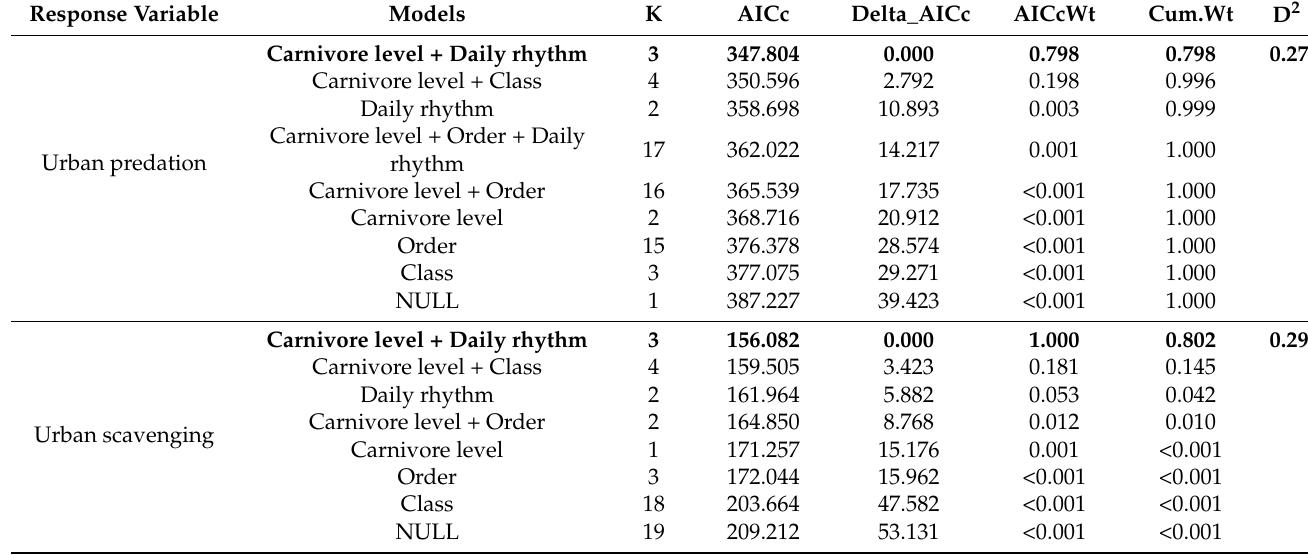
In urban predation and scavenging studies, the most recorded species were those with meat-based diets and nocturnal activity (Table 3). In both sets, there were other models that included the explanatory variables carnivorous level and class (Table 3), at only a few tenths above the threshold of 2 ∆ AICc. The selected models explained an important fraction of the deviance (0.27 in the case of the urban predation model and 0.29 in the case of the urban scavenging model) (Table 4). Both models showed very low values of over-dispersion (0.63 in the case of the urban predation model and 0.18 in the case of the urban scavenging model). Table 3. AIC-based model selection to assess the characteristics of the scavenger species most recorded. Only models with informative variables are included. Model selected is represented in bold. Number of estimated parameters (K), AICc values, AICc differences ( ∆ AICc) compared to the highest ranked model (i.e., the one with the lowest AICc), Akaike weights (AICcWt), Cumulative weight (CumWt) and the variability of the models explained by the predictors (D 2 ) are